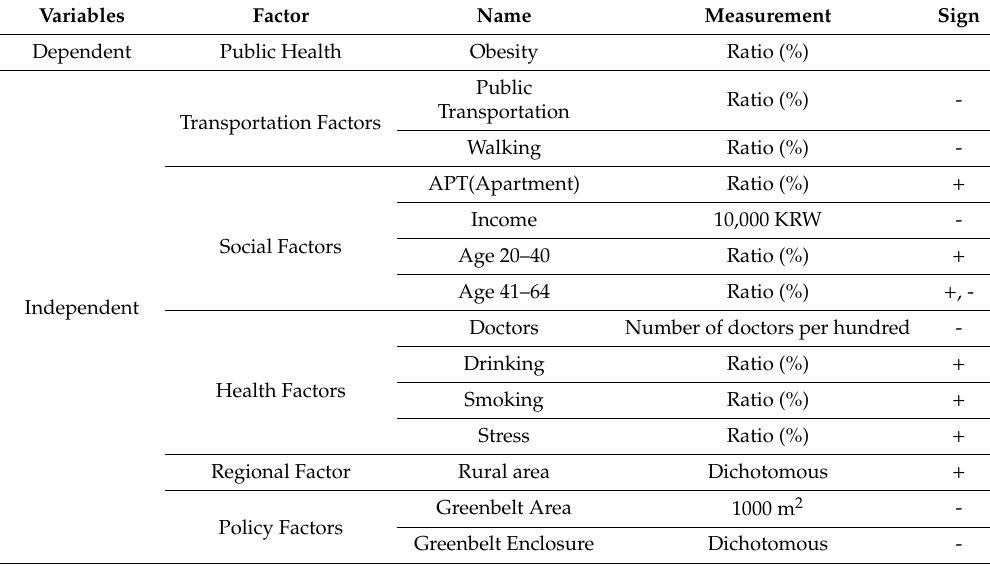
Table 1. Variable definitions, measurements, and expected